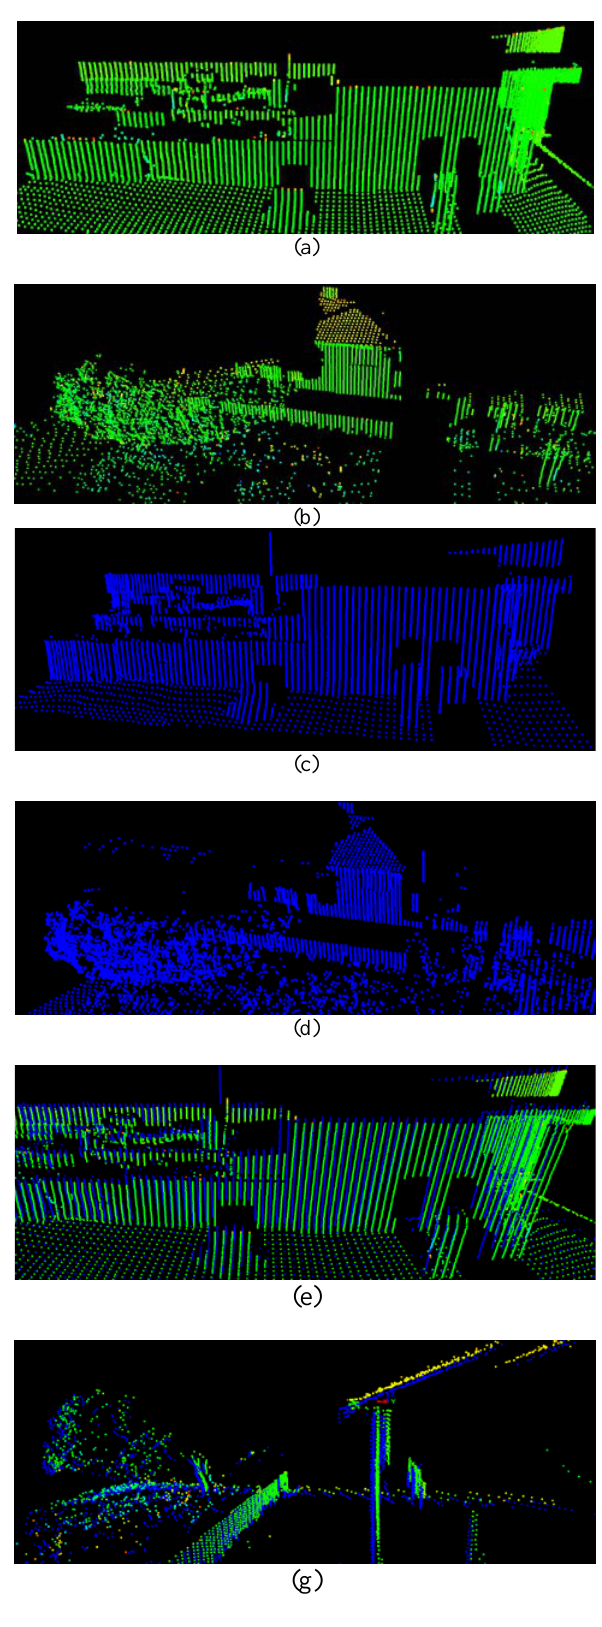
Figure 2 Captured point clouds: (a) and (b) dataset 1; (c) and (d) dataset 2; (e) and (g) misalignment between data set 1 and